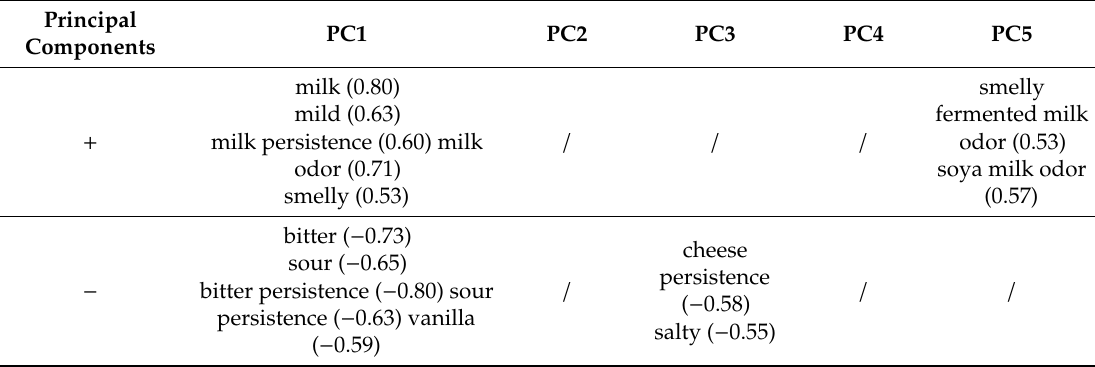
Table 2. Correlation matrix (Pearson’s